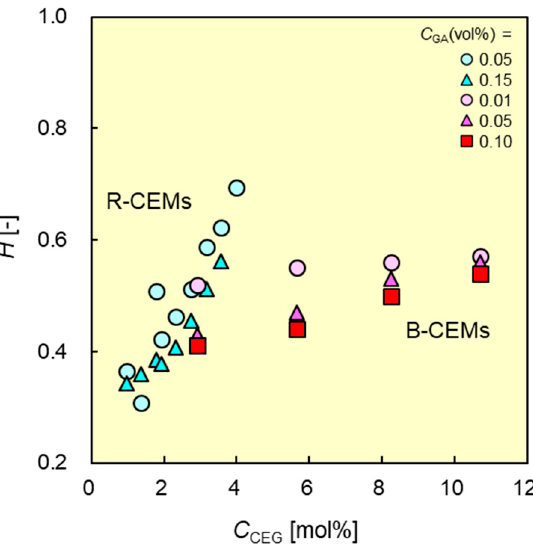
Figure 5. Water contents H of B-CEMs and R-CEMs as functions of content C CEG of cation-exchange groups in copolymers. Red and blue symbols denote the data of B-CEMs and R-CEMs, respectively.